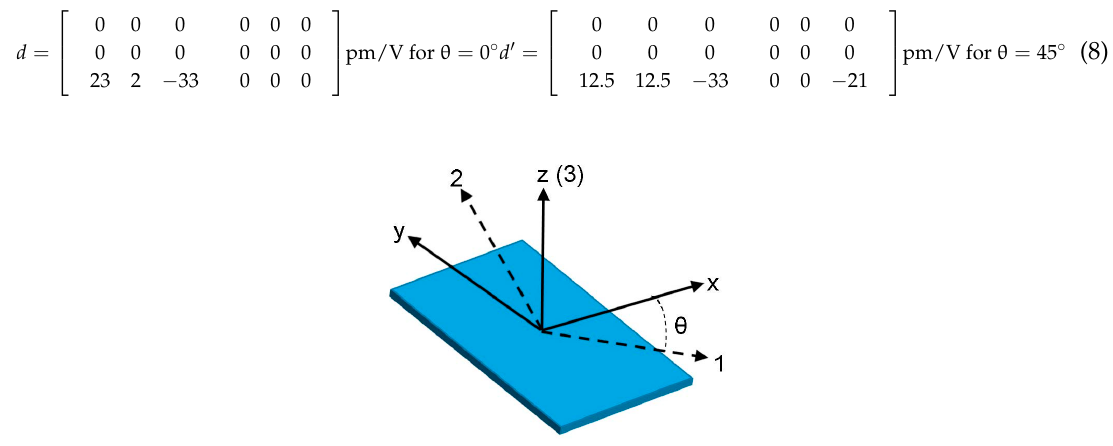
Figure 2. The (cid:2186) (cid:2780)(cid:2783)(cid:4593) coefficient for the rotation angles from − 90° to 90°.